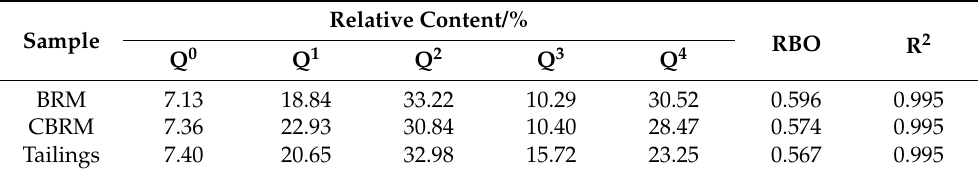
Table 4. The RBO of BRM, CBRM, and